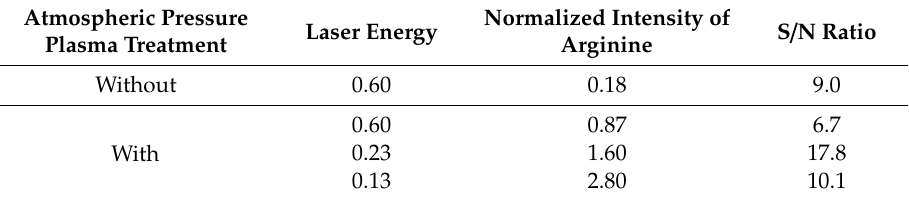
Figure 7. Mass spectra of arginine with and without hydrophilic treatment. Table 1. Normalized signal intensity of arginine and signal-to-noise (S / N)